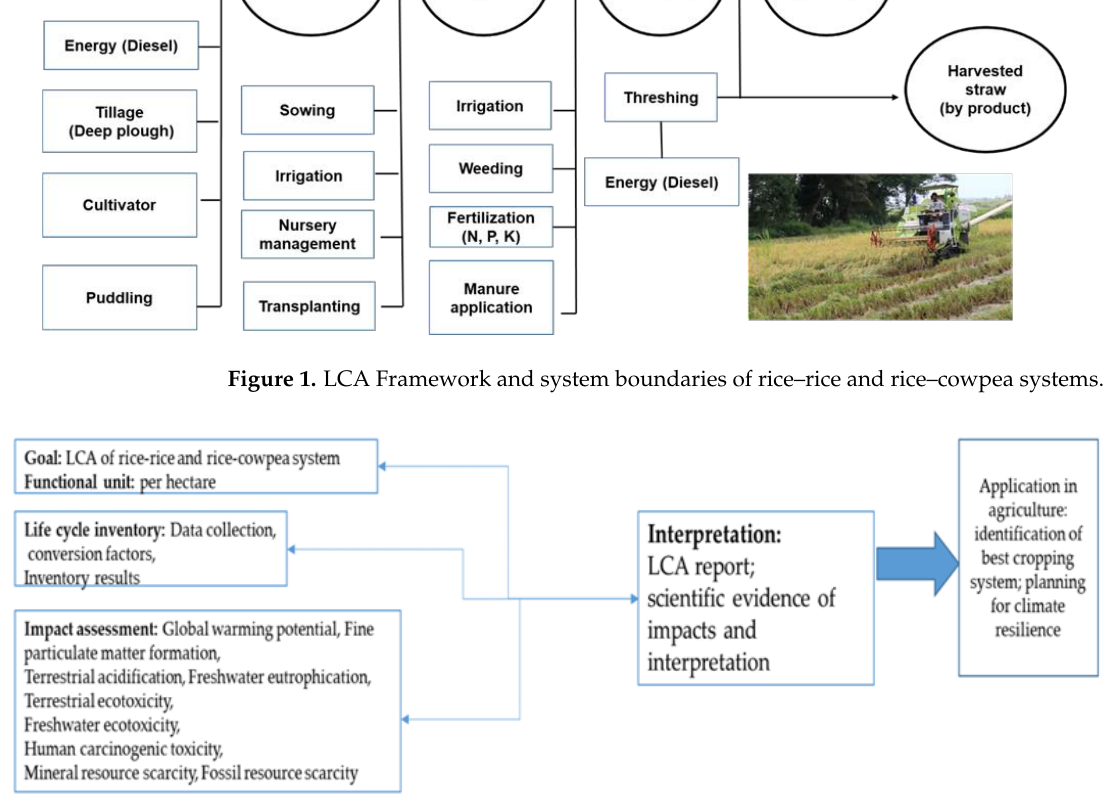
Figure 2. LCA flowchart depicting phases and